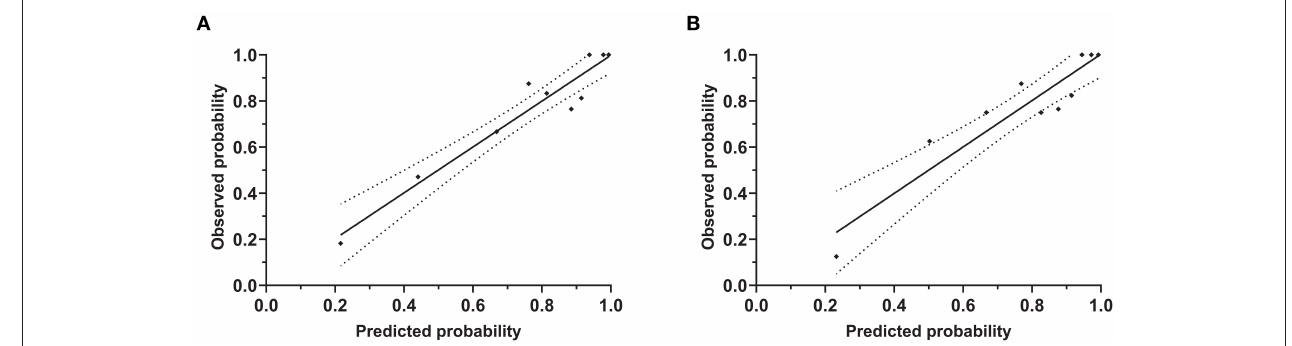
FIGURE 6 | Calibration plot of risk estimation for proteinuria prediction model. These plots showed the calibration accuracy of the models between observed and predicted probabilities (Hosmer Lemeshow test). The X-axis and Y-axis indicated the predicted and observed probabilities of proteinuria from the initial model (A) and adjusted model (B) ,